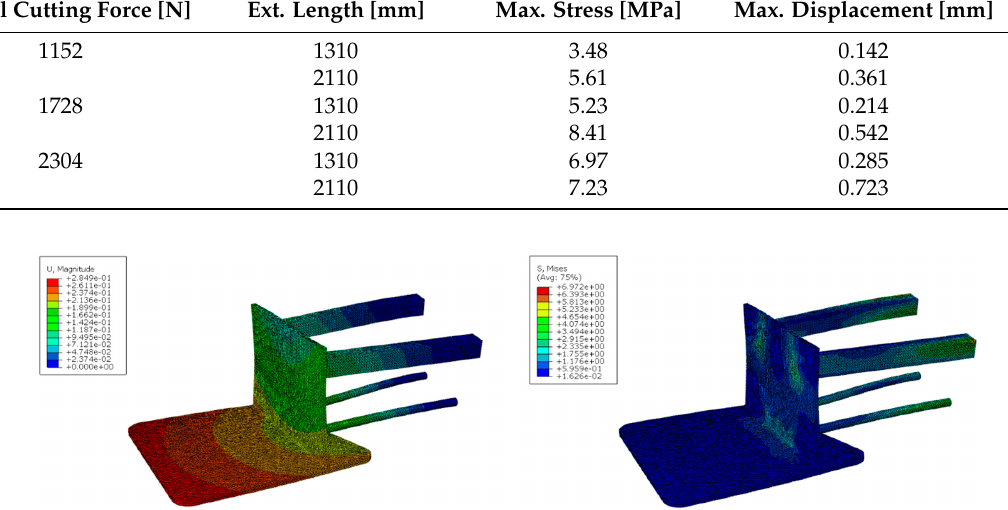
Figure 5. Displacement and effective stress distribution in the concept model of the adapter for Table 5 according to the extension length of 1310 mm and the cutting force of 2340 N. Table 5. Maximum stresses and maximum displacements from the overall cutting forces calcu- lated at the chip surface A chip .